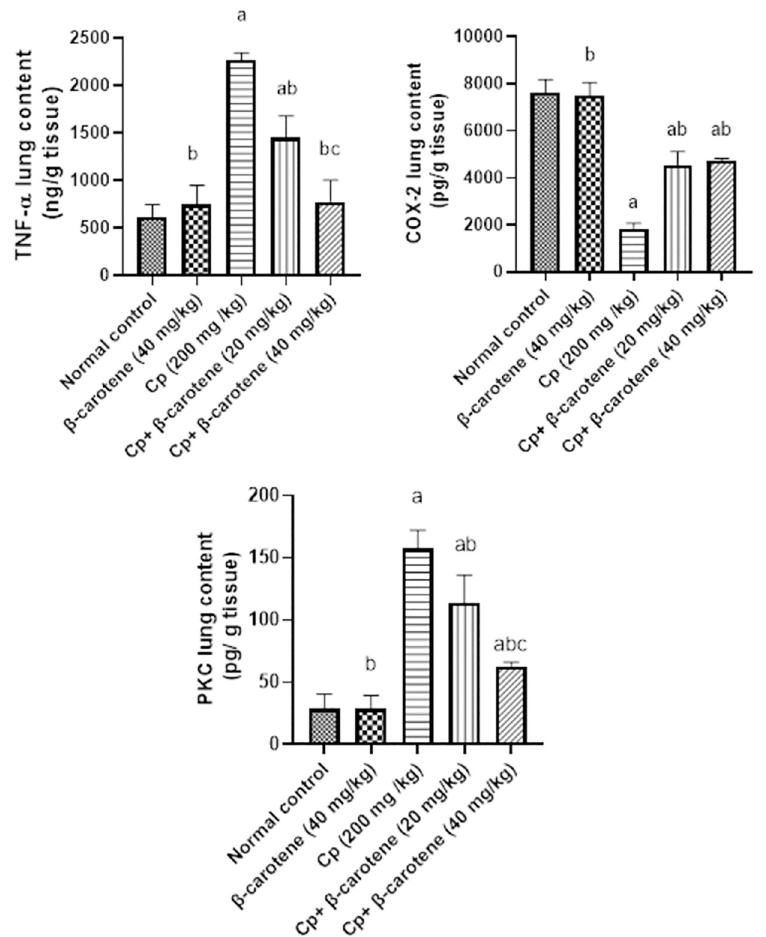
Fig 6. Effect of β -carotene on TNF- α , COX 2, and PKC lung contents. a Significantly different from the control group. b Significantly different from the CP group. c Significantly different from the CP + β -carotene 20 mg/kg group at P < 0 . 05